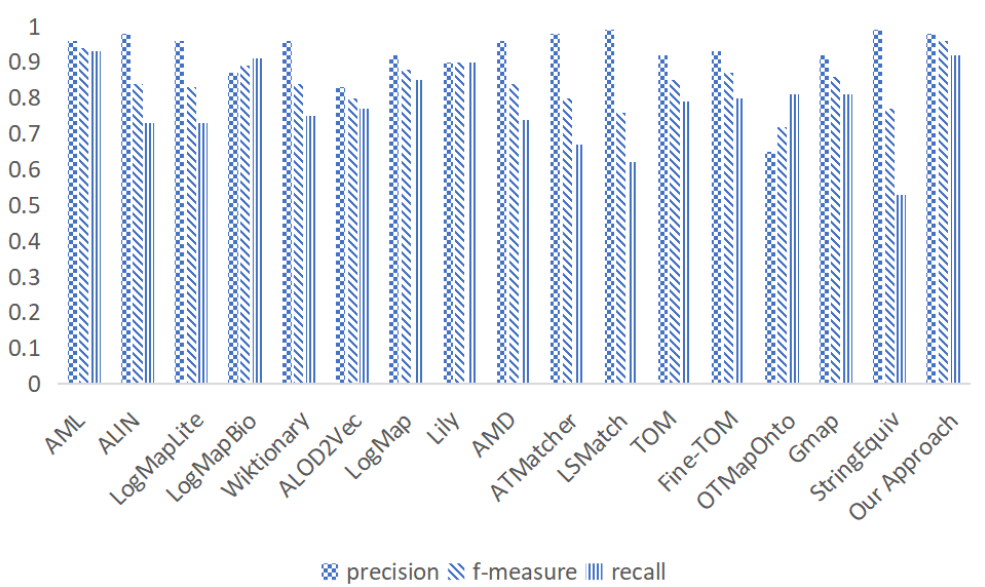
Figure 8. Comparison With OAEI’s Participants On OAEI’s Anatomy